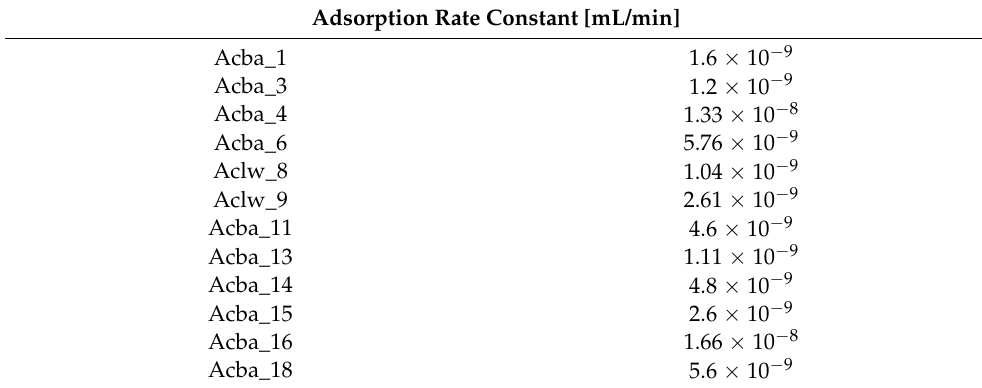
Table 6. Basic features of sequenced phages.